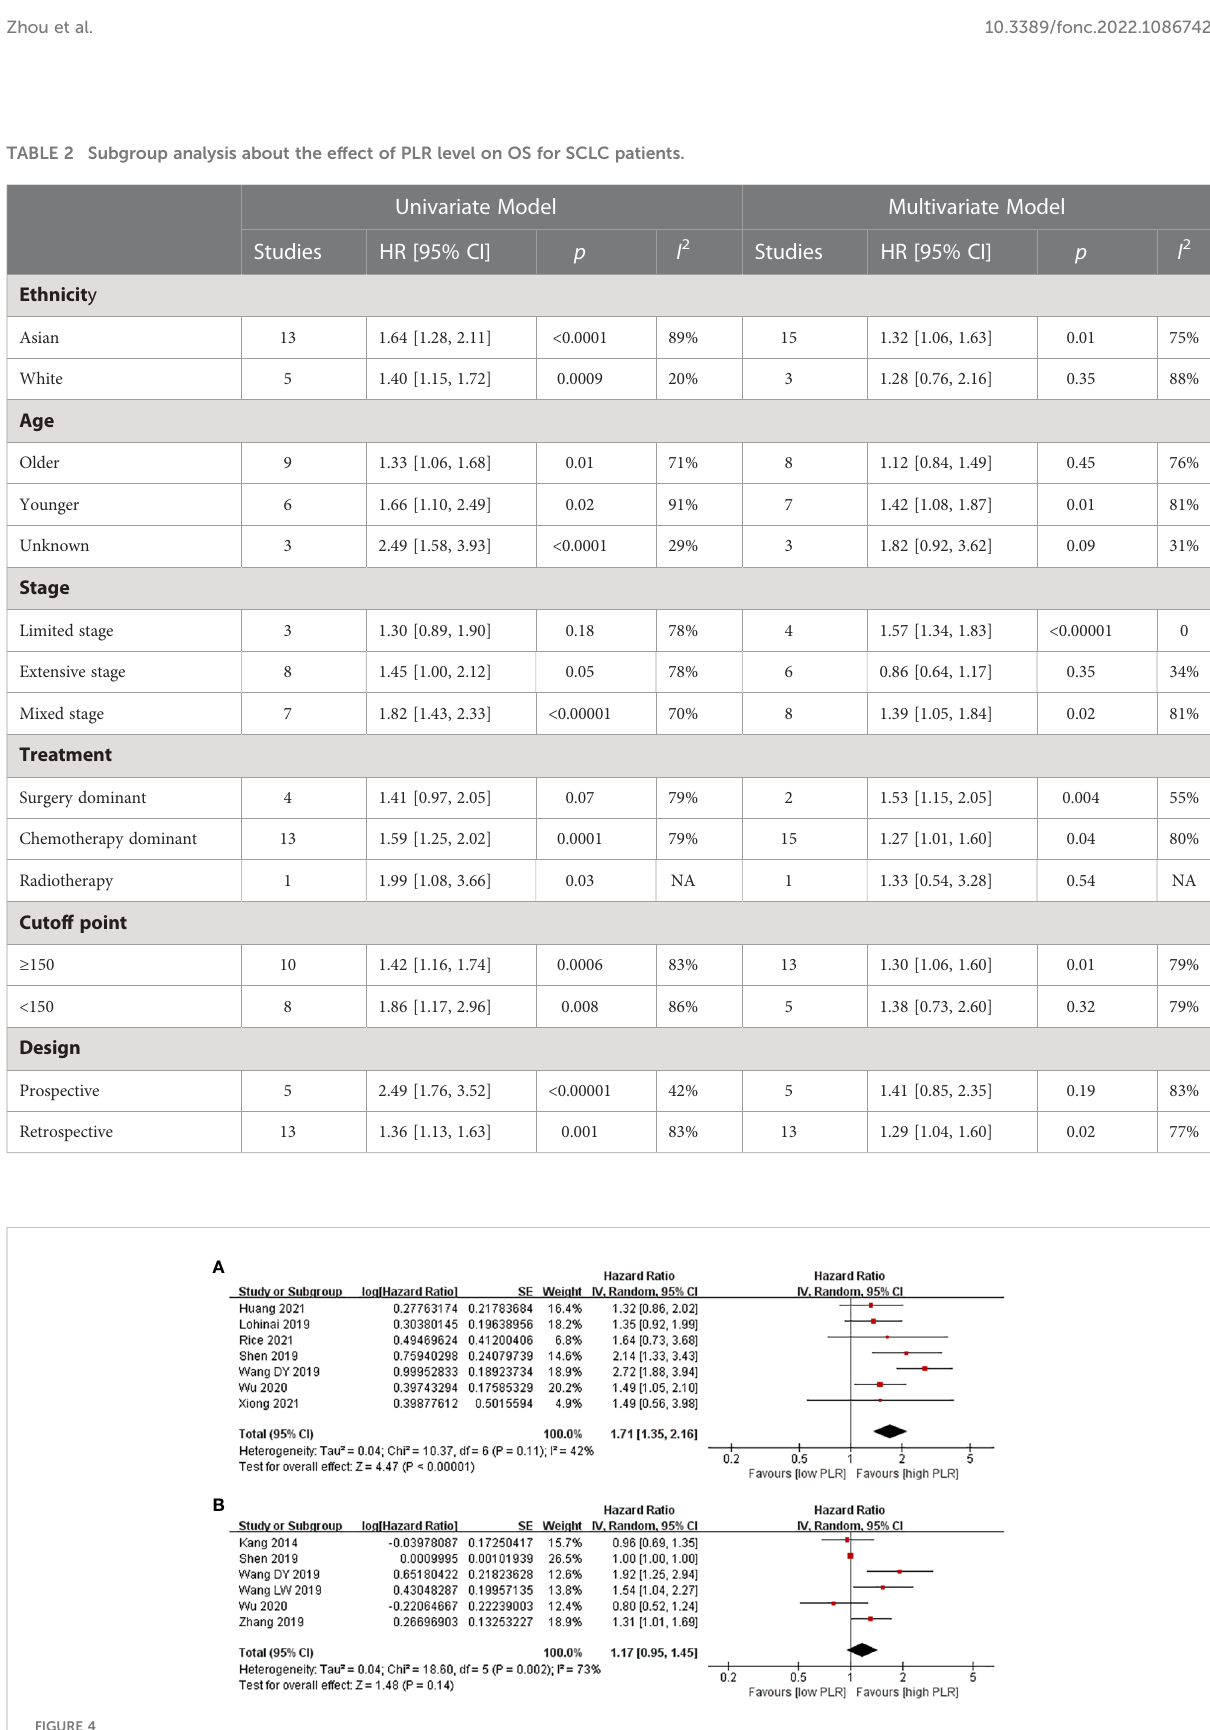
FIGURE 4 Associations between PLR and PFS in SCLC patients. (A) Univariate model; (B) multivariate